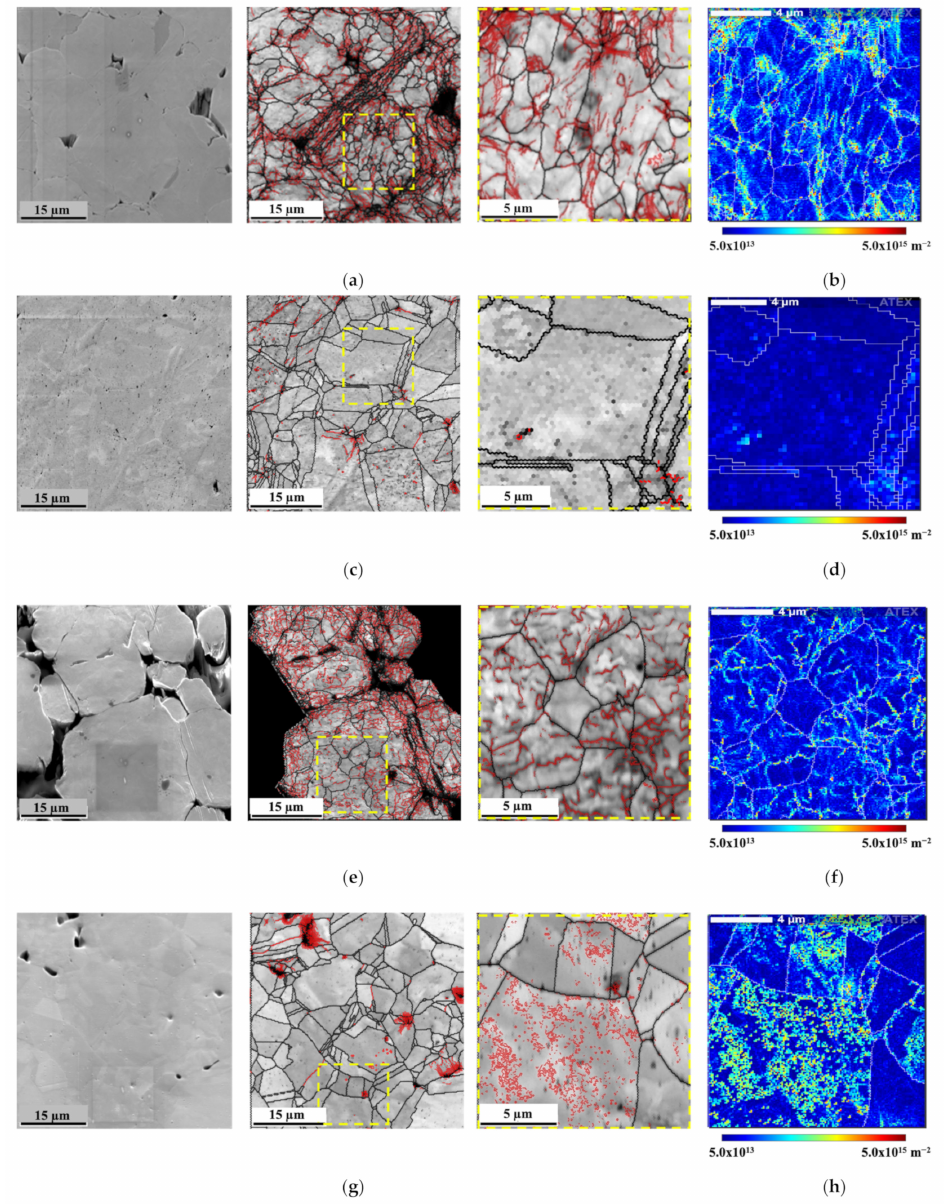
Figure 8. SEM images and IQ maps with high- and low-angle boundaries (black and red, respectively) delimited and geometrically necessary dislocation (GND) density maps for ( a , b ) Ni green compact, ( c , d ) sintered Ni, ( e , f ) Ni-CNT green compact, and ( g , h ) Ni-CNT sintered